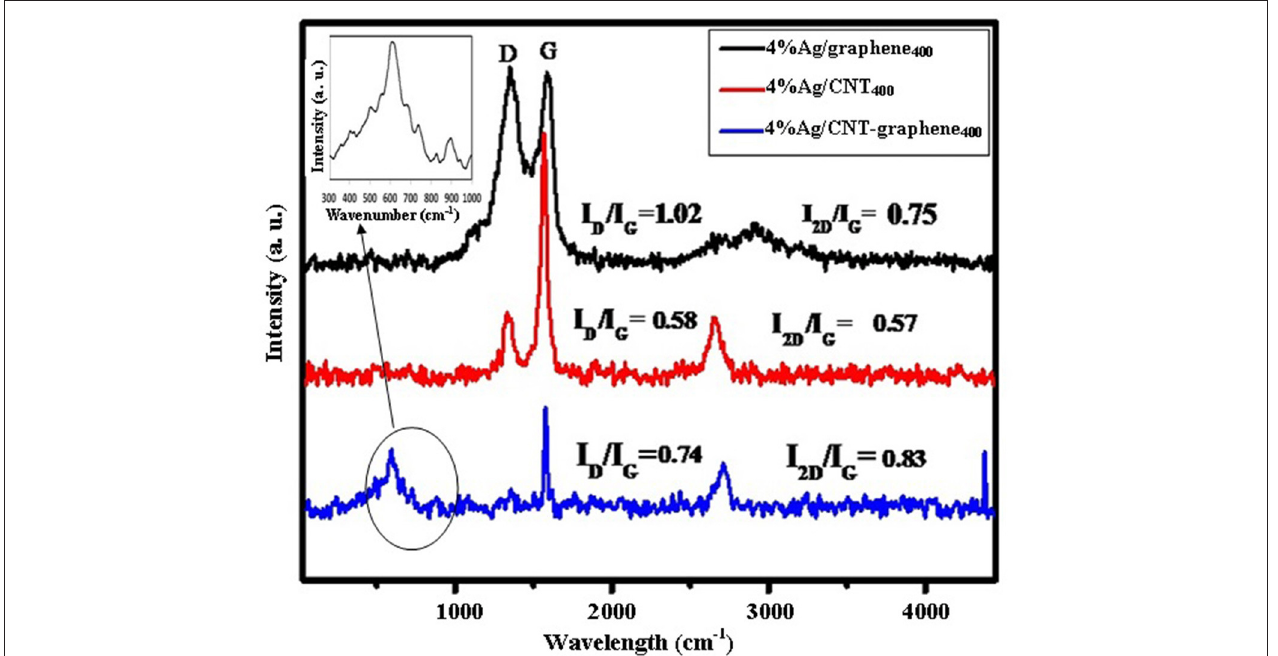
FIGURE 4 | Raman spectra of 4%Ag/graphene 400 , 4%Ag/CNT 400 , and 4%Ag/CNT-graphene 400 .